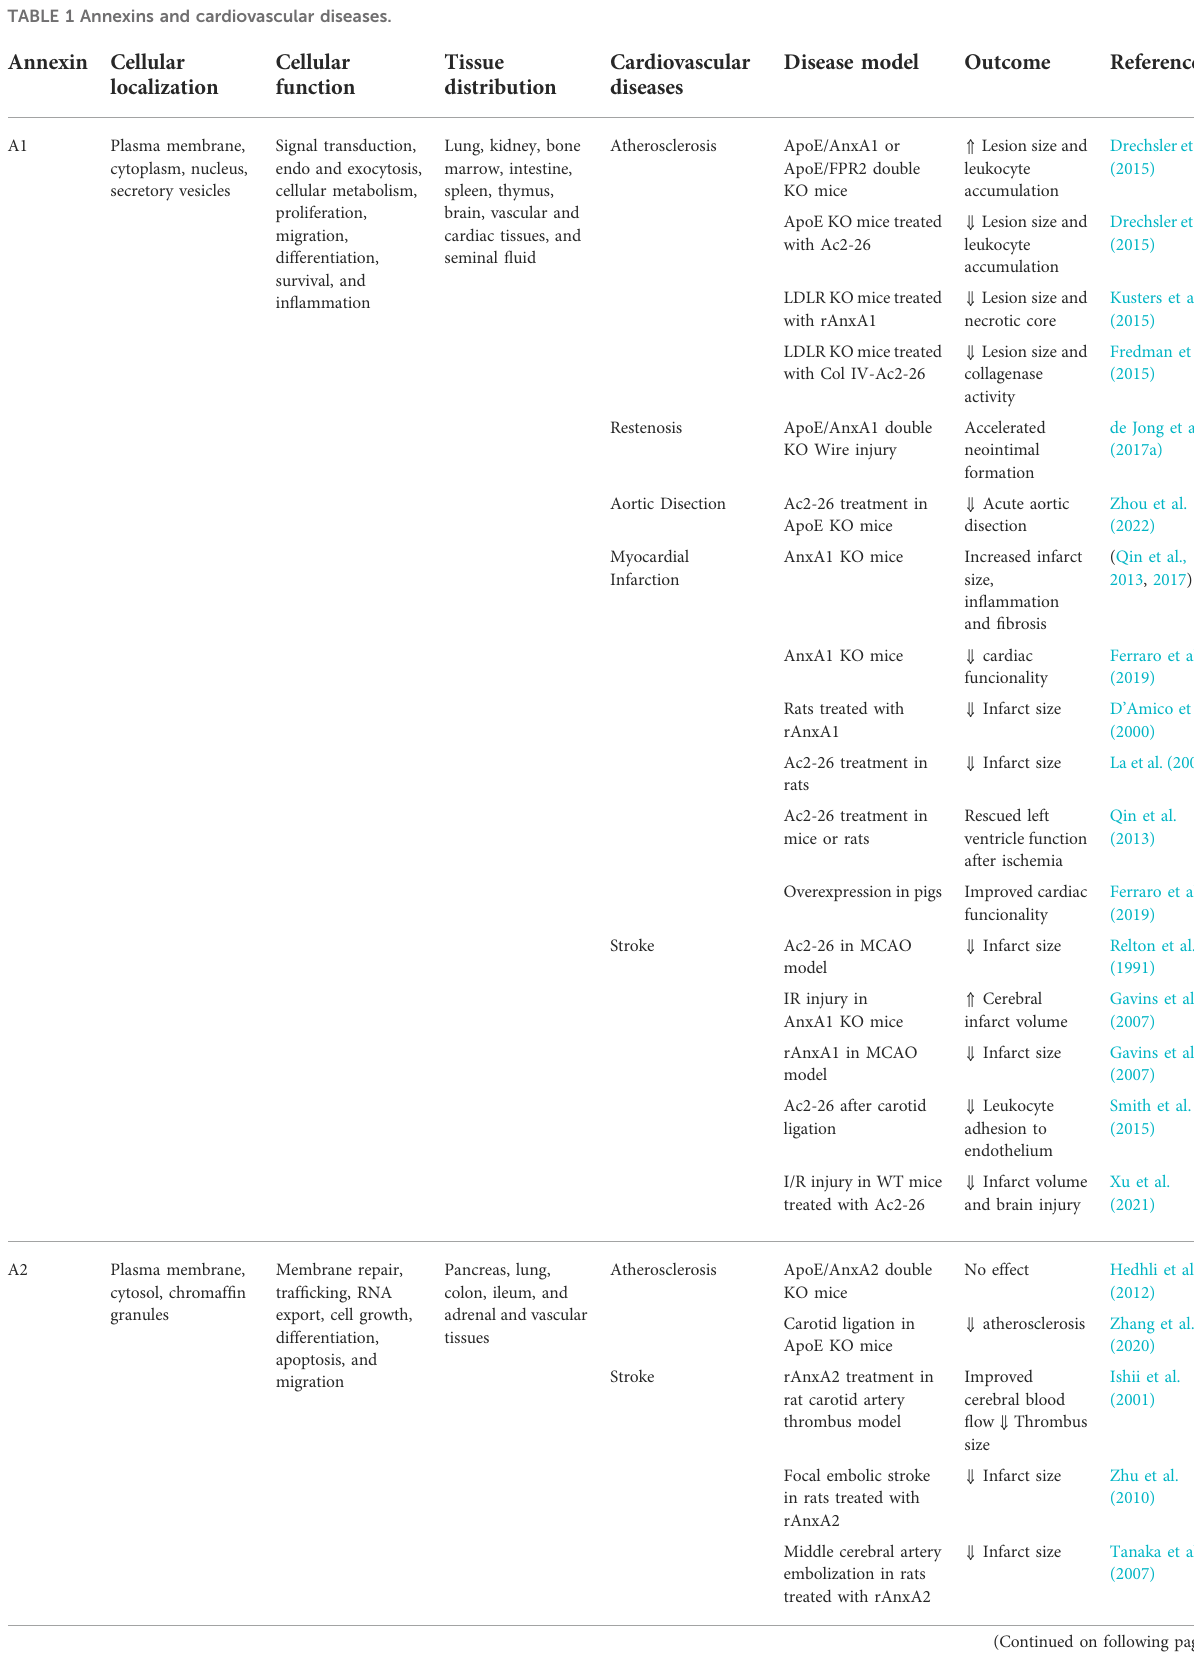
TABLE 1 Annexins and cardiovascular